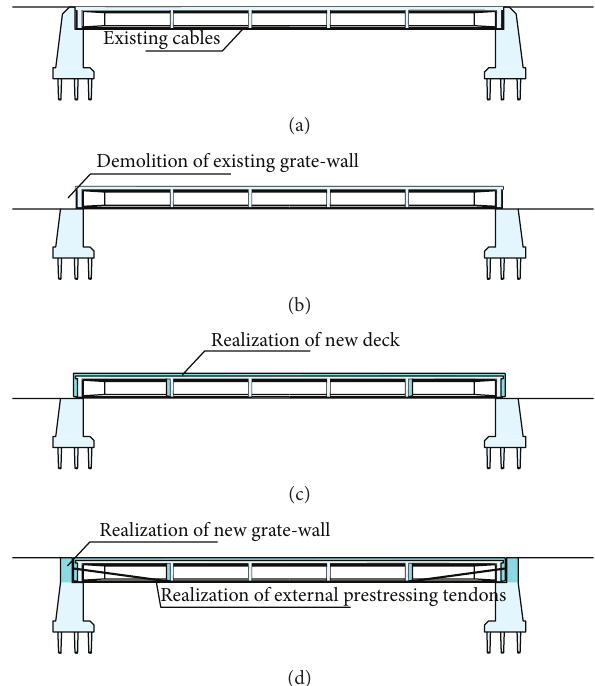
Figure 1: Longitudinal section of (a) existing bridge, (b) demolition of gravel-grate walls and elimination of road superstructure, (c) realization of a new deck, and (d) realization of new gravel-grate walls and a system of external